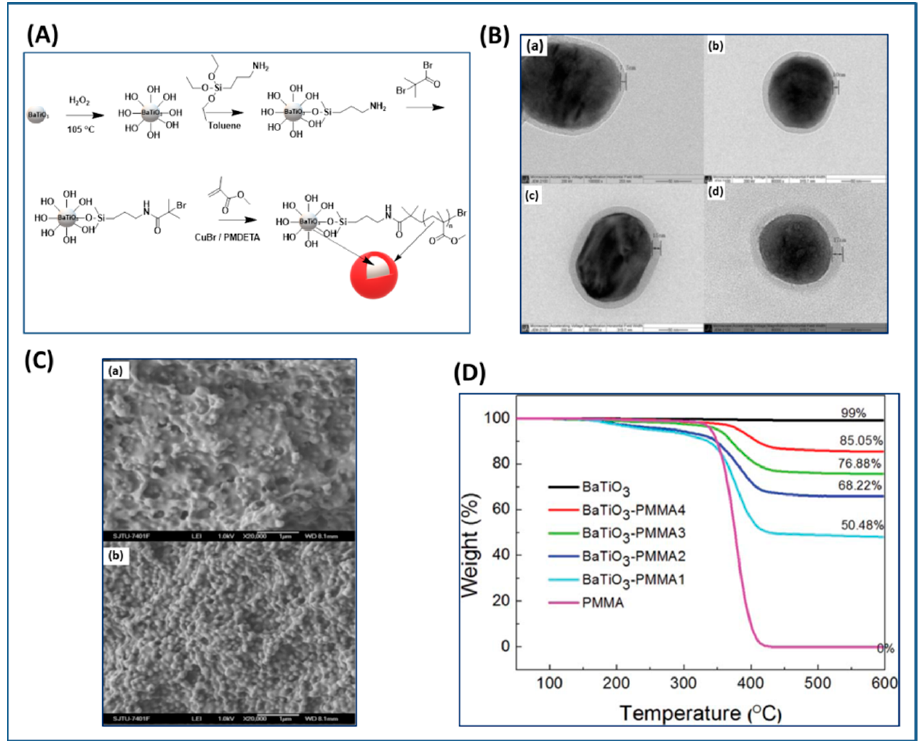
Figure 5. ( A ) Schematic diagram illustrating ATRP approach of growing PMMA from BaTiO 3 ( B ) TEM images of PMMA-BaTiO 3 ( a ), PMMA3-BaTiO 3 ( b ) PMMA2-BaTiO 3 ( c ), PMMA1-BaTiO 3 ( d ). ( C ) SEM of the cross-sectional images of composite films: PMMA1-BaTiO 3 ( a ) and PMMA2-BaTiO 3 ( b ). ( D )TGA curves for the pure PMMA and PMMA-BaTiO 3 . Reproduced with permission from Ref [119].